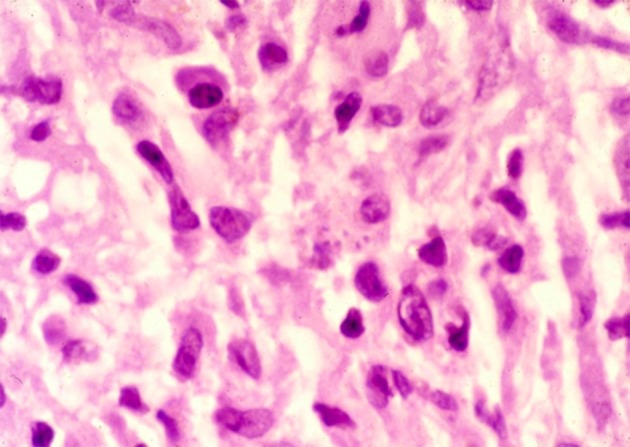
Parasites can be seen in a skin biopsy taken from a PKDL lesion.